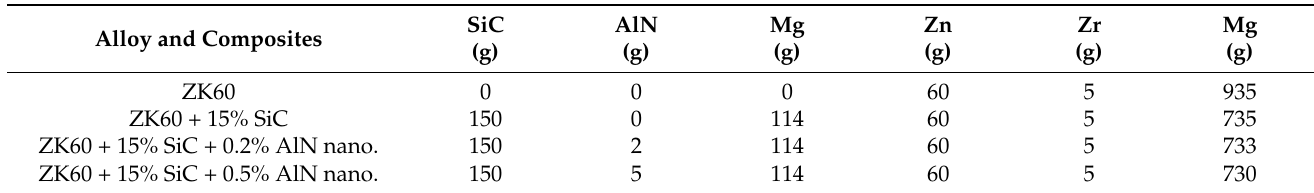
Table 2. The amount in grams of the content of the investigated ZK60 and ZK60 alloys with 45 µ m,